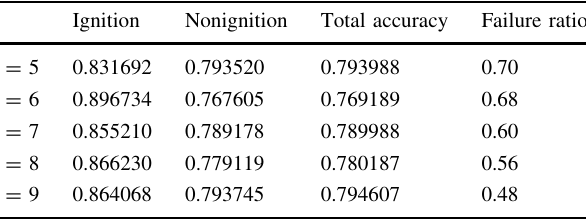
Table 5 Prediction precision of the ANN models